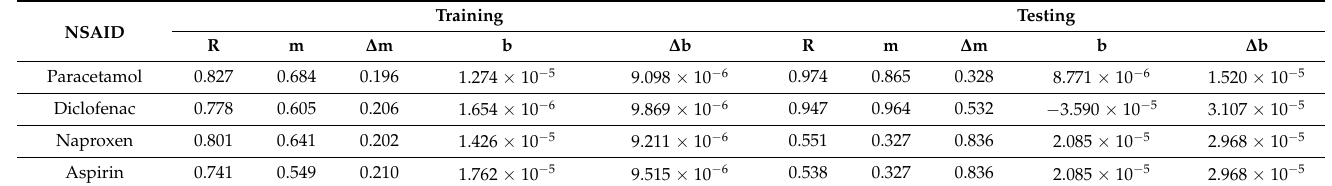
Table 2. Linear regression parameters for the comparison of the obtained vs. expected data with the training and testing data sets using a PLS model with 12 components. Training